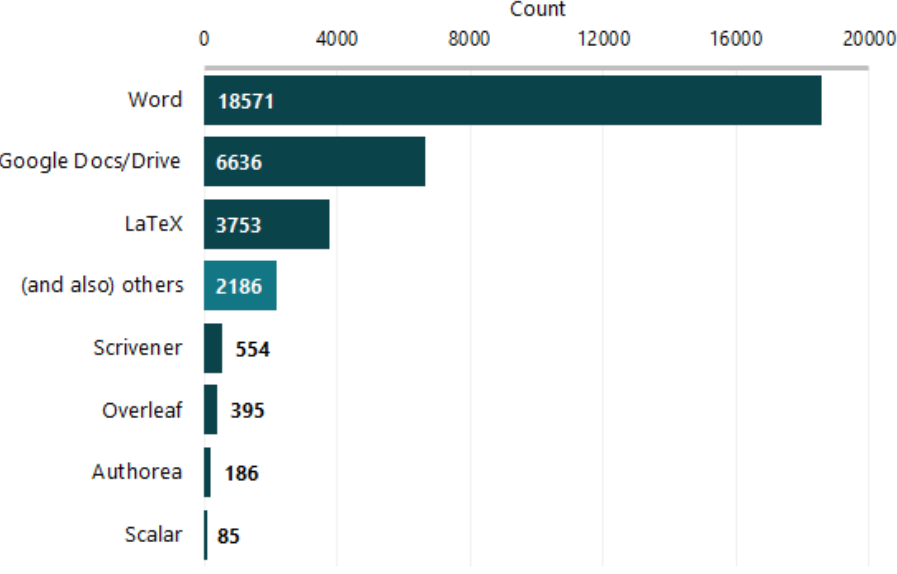
Free software such as LibreOffice (https://www.libreoffice.org/discover/libreoffice/) and OpenOffice (https://www.openoffice.org/) has significantly fewer users (267 and 215 users